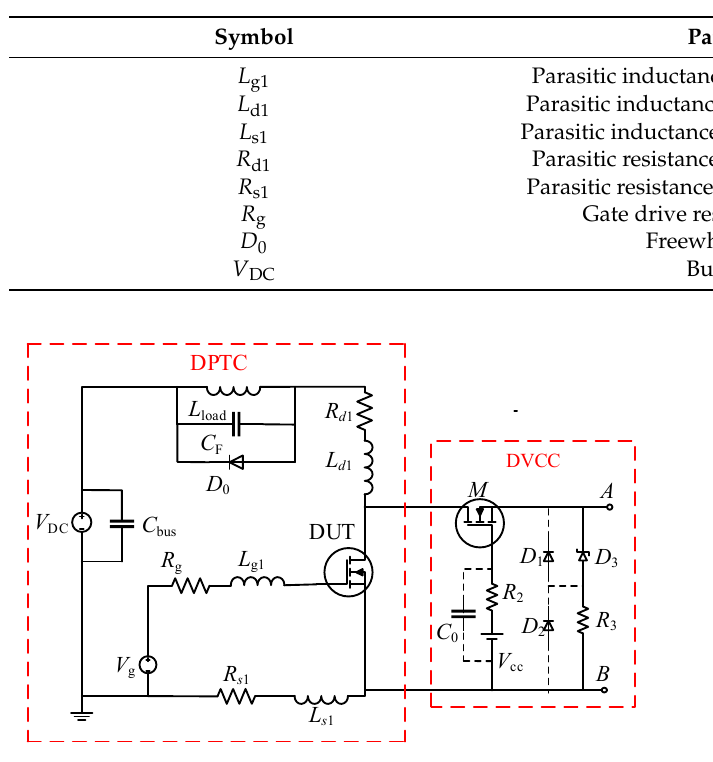
Figure 5. Equivalent simulation circuit.